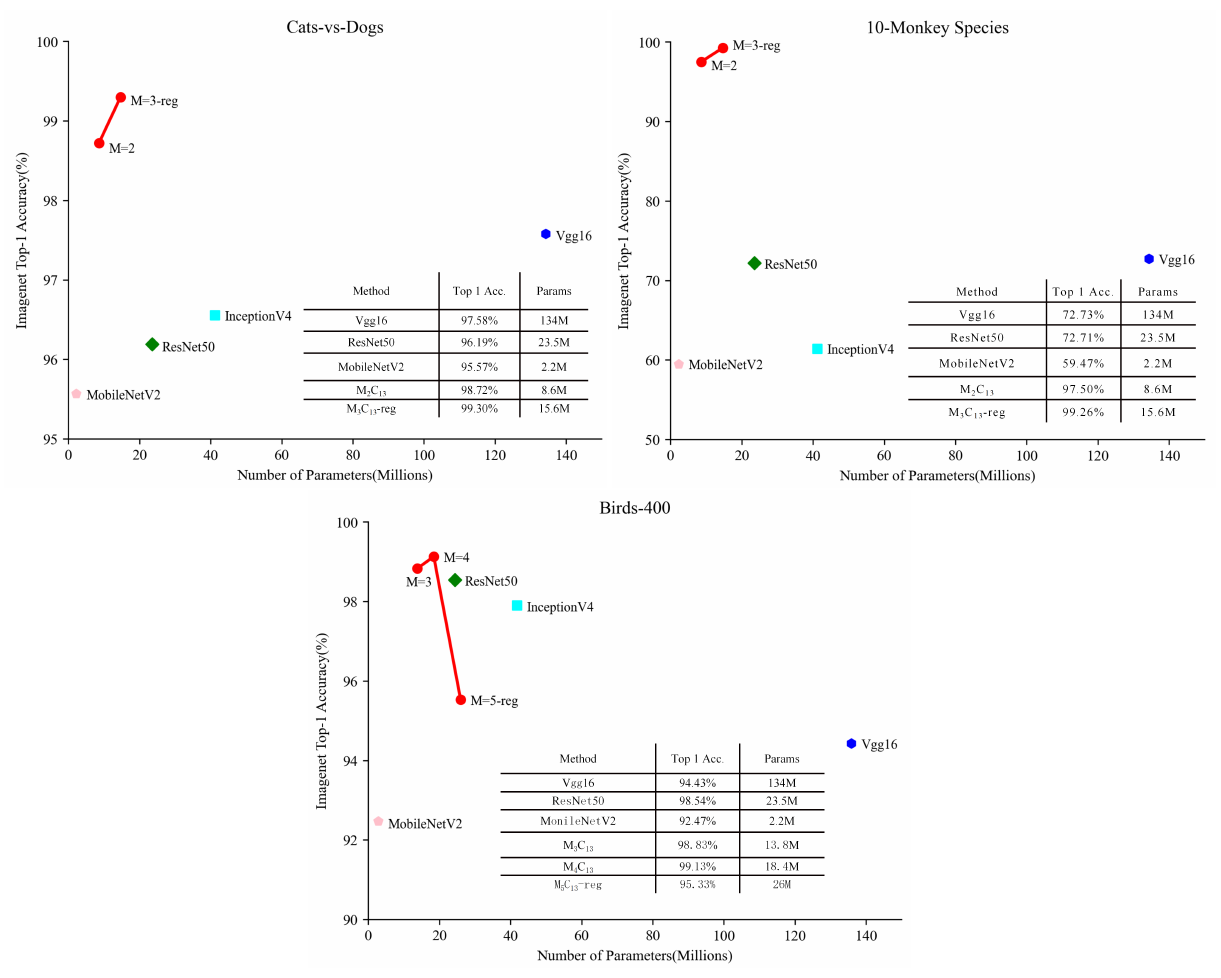
Figure 5. Model Parameters vs. Datasets Accuracy. Table 3. Evaluation Results in the Cats-vs.-Dogs Dataset.